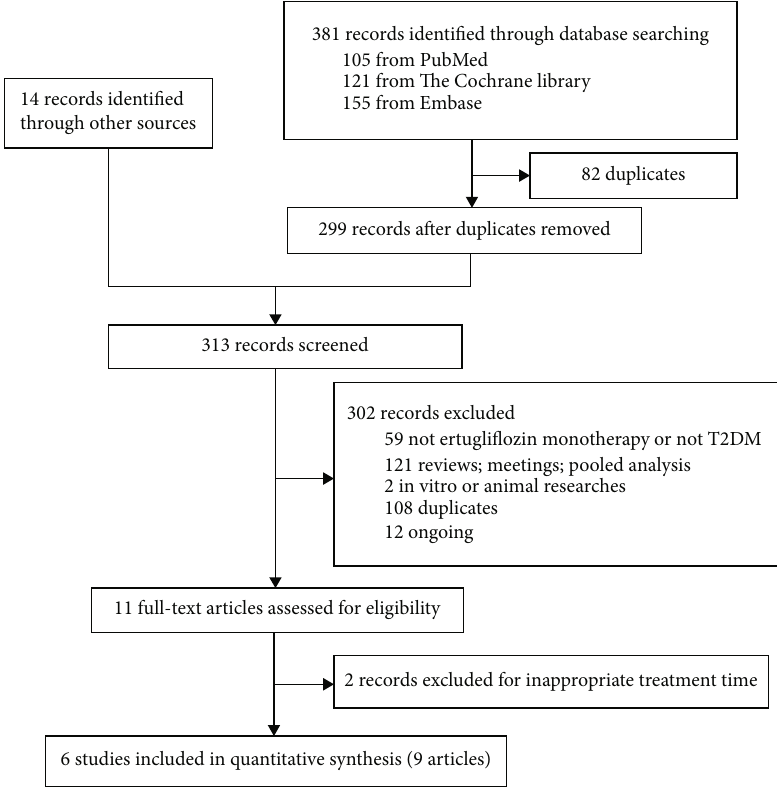
Figure 1: Flow chart of the literature search